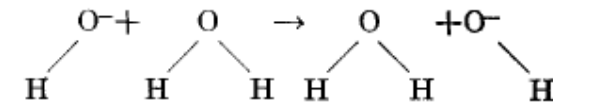
Figure 2. Proton transfer mechanism of hydroxide ions